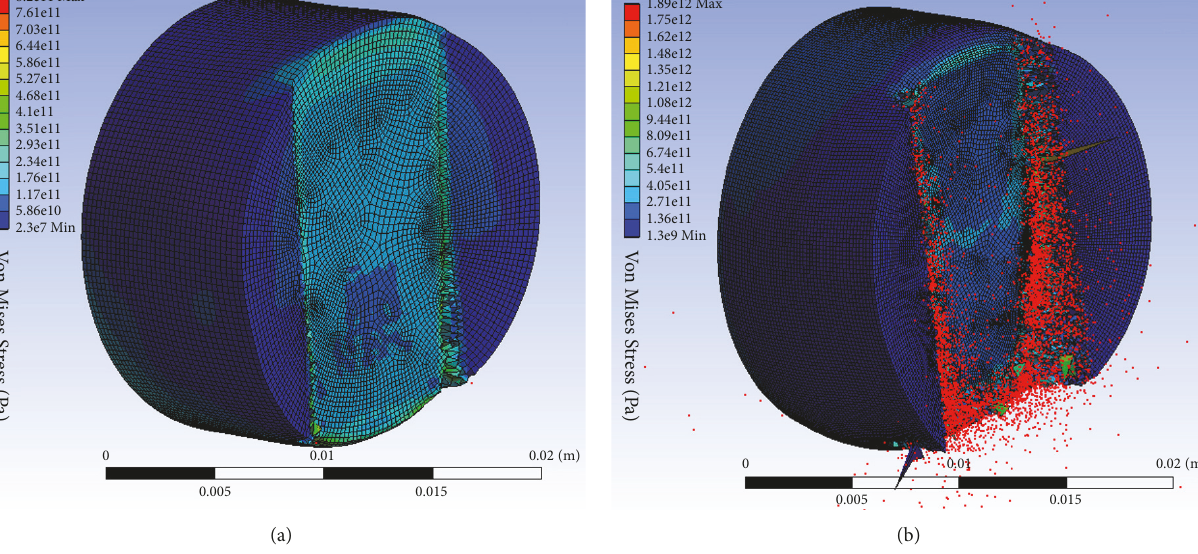
Figure 11: Stresses resulting from impact simulation of pure diamond sample without lattice: (a) 1000 J and (b) 5000 J impact